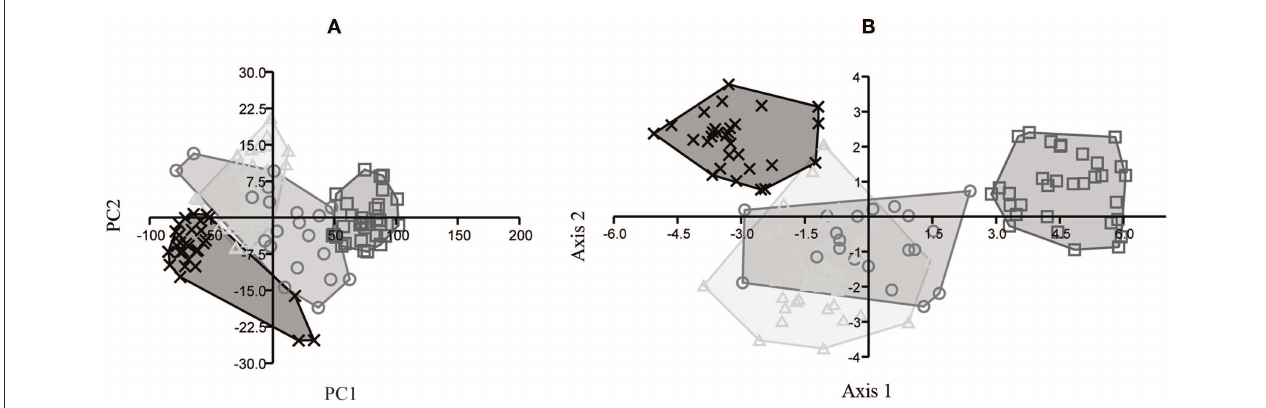
FIGURE 7 | MTIII analysis for E. andium (x), E. insulatus (triangle), E. neogeus (circle), and E. occidentalis (box): (A) projected scores from PCA, PC1 (96%) and PC2 (2%); (B) dispersal graph from CVA, axis 1 (77%) and axis 2